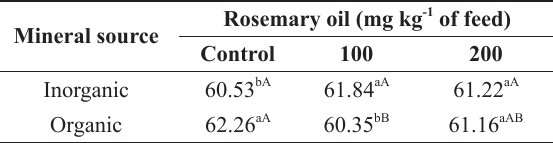
Average egg weight of layers fed different mineral sources and rosemary oil levels.